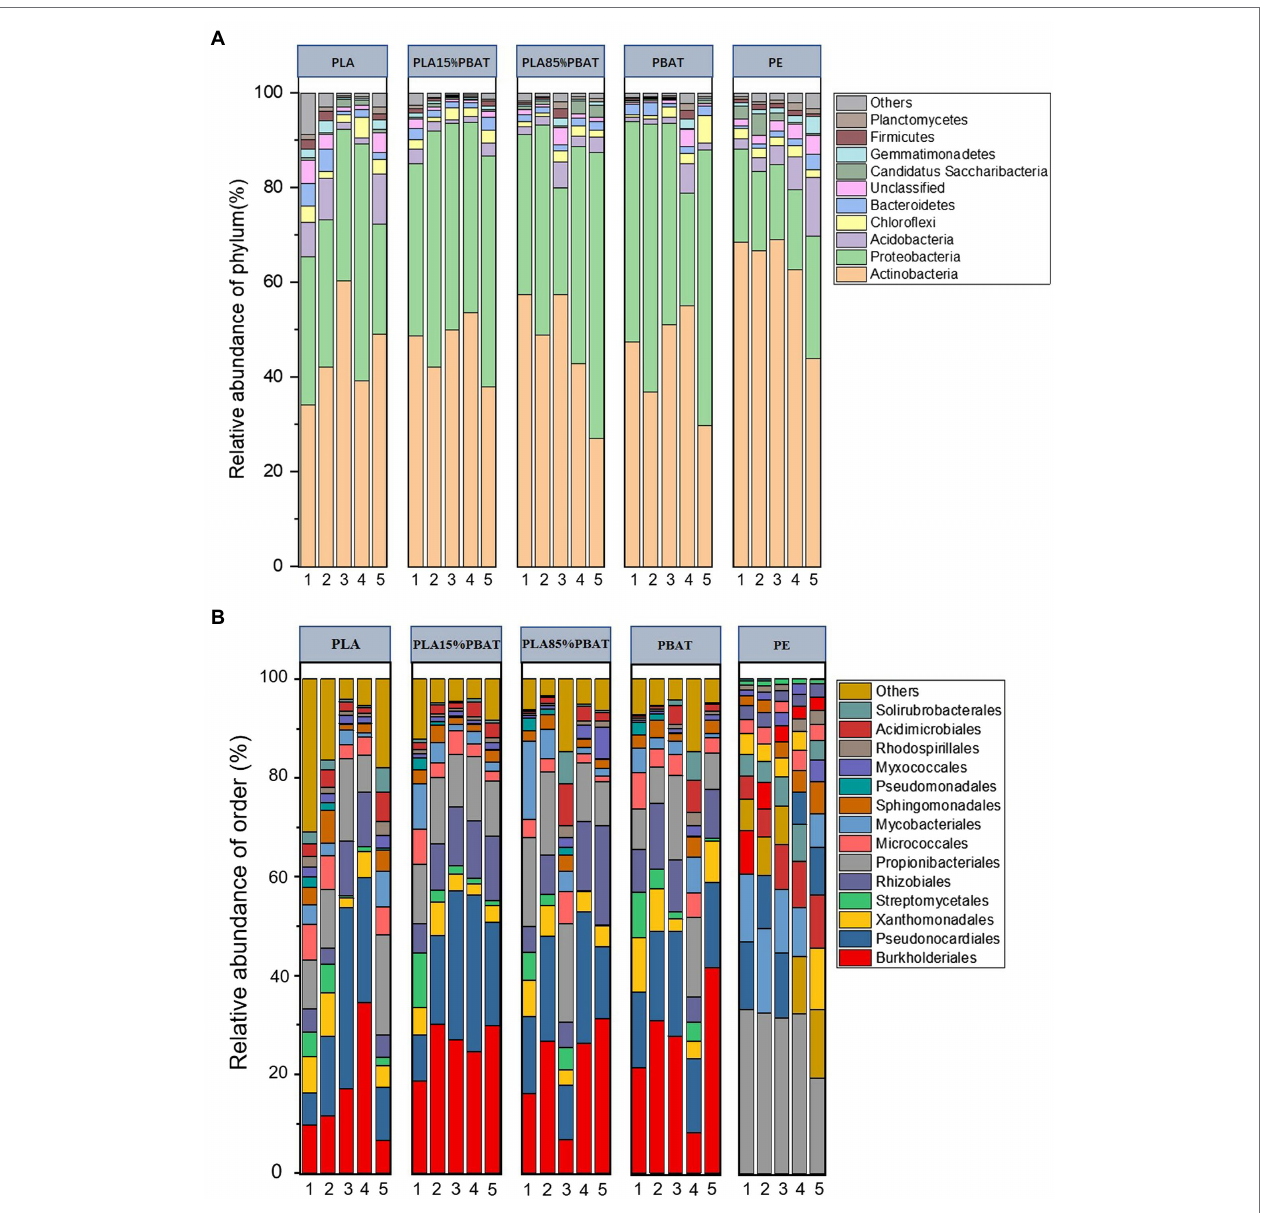
FIGURE 2 | Relative abundance of bacterial phyla and order over 5 months. Stacked bar chart of the top 10 bacterial phyla (A) and the top 14 bacterial orders (B) with the largest mean relative abundance. The numbers 1–5 represent 5 months, respectively (A,B) .